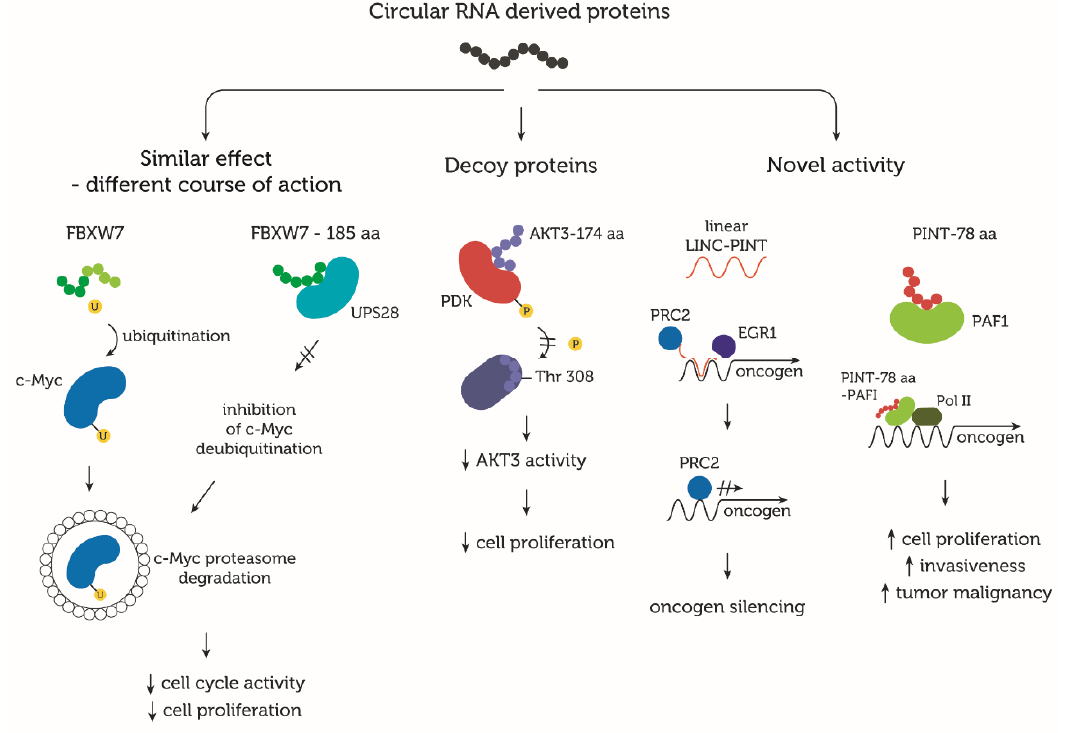
Figure 2. Examples of circRNA-derived proteins and their activity. Some proteins originating from circRNAs share the same activity as their linear-derived counterparts, but their goals are achieved in di ff erent manners. FBXW7-185aa arrests cell cycle and cell proliferation, but, in contrast to FBXW7, it cannot directly interact with c-Myc. It a ff ects c-Myc ubiquitination via the activation of the deubiquitinating enzyme,